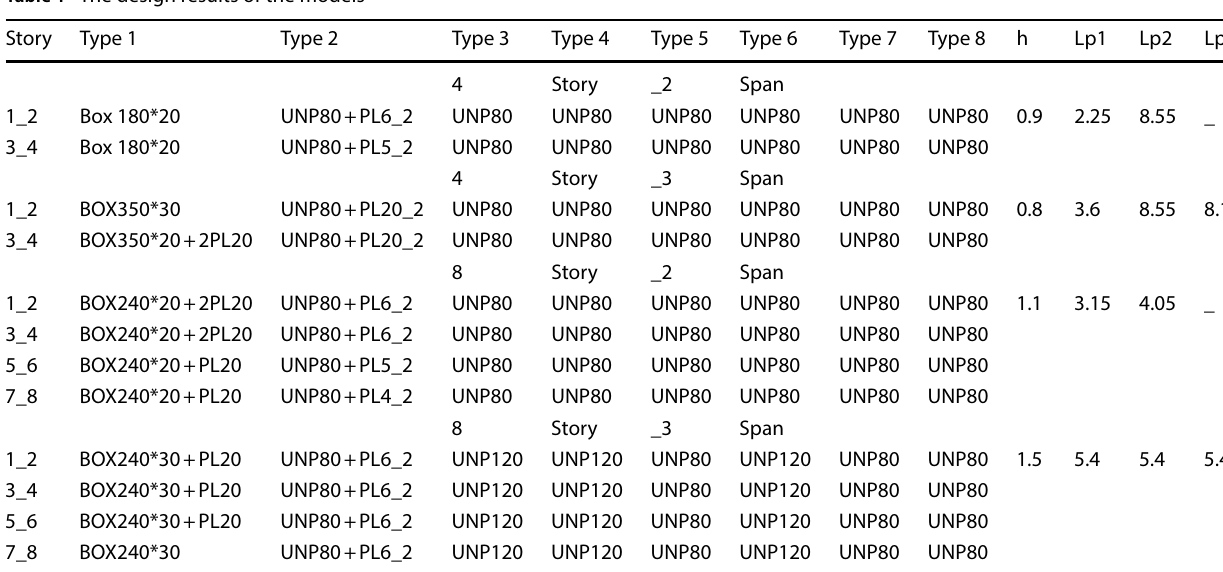
Table 1 The design results of the